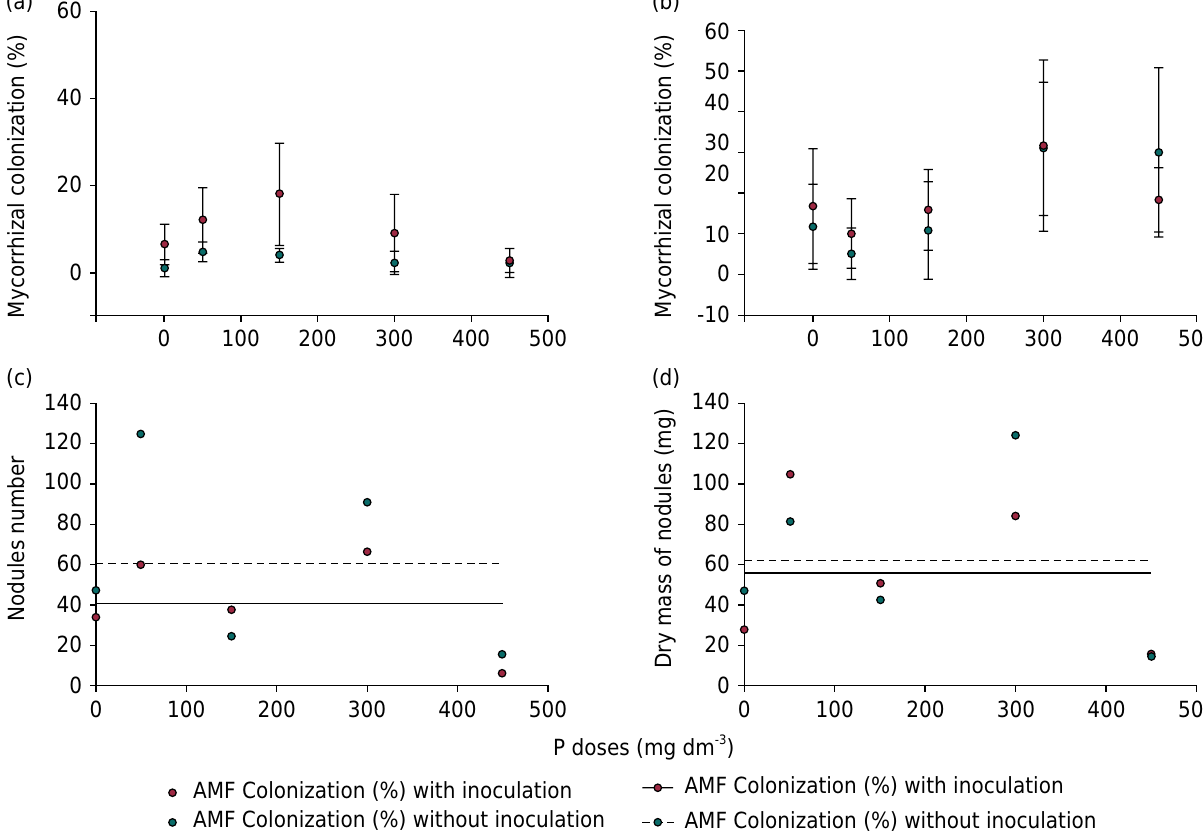
Figure 4. The percentage of mycorrhizal colonization of P . reticulata (a) and M . brauna (b) and number (c) and dry matter of nodules (d) in M . brauna after 90 days of cultivation, fertilized with P (0, 50, 150, 300, and 450 mg dm -3 of soil), inoculated or not with three species of arbuscular mycorrhizal fungi ( Claroideoglomus etunicatum , Rhizophagus clarus , Gigaspora albida ). Bar: standard